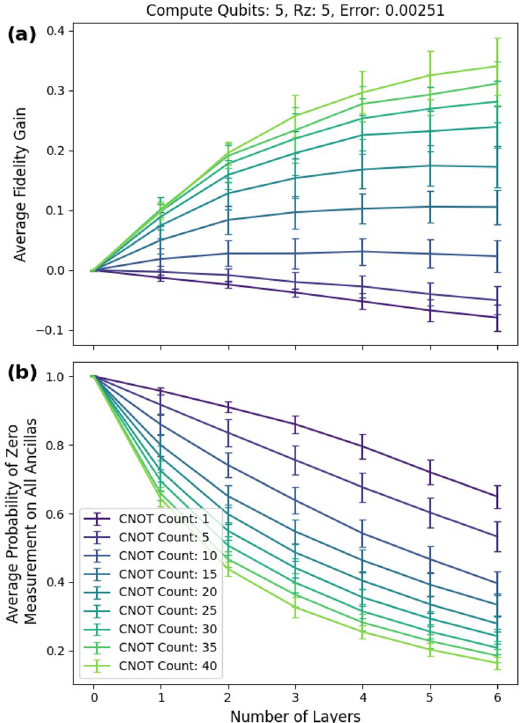
Figure 12. ( a ) Average fidelity gain vs number of layers. ( b ) Probability of postselecting vs number of layers. The single-qubit error is fixed at approximately 0.00251 (0.0251 two-qubit error).